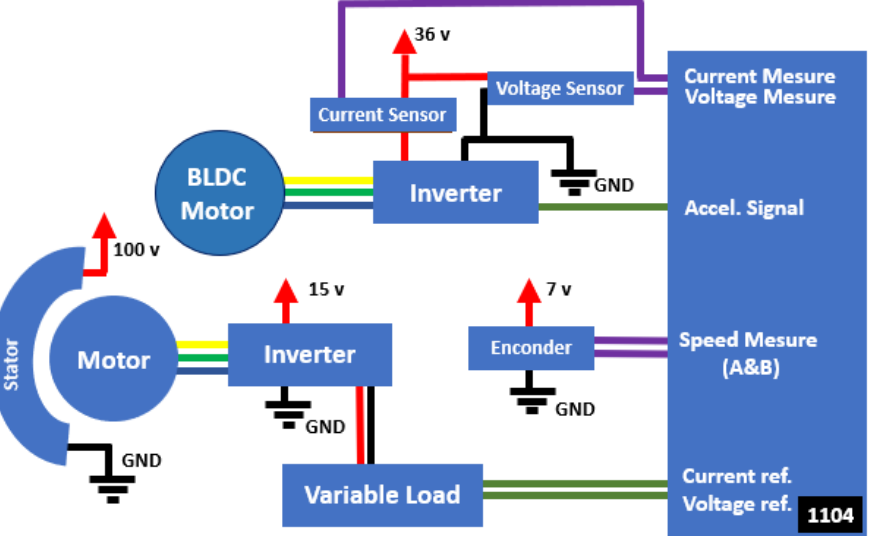
Figure 6. Electrical diagram of the test bench.